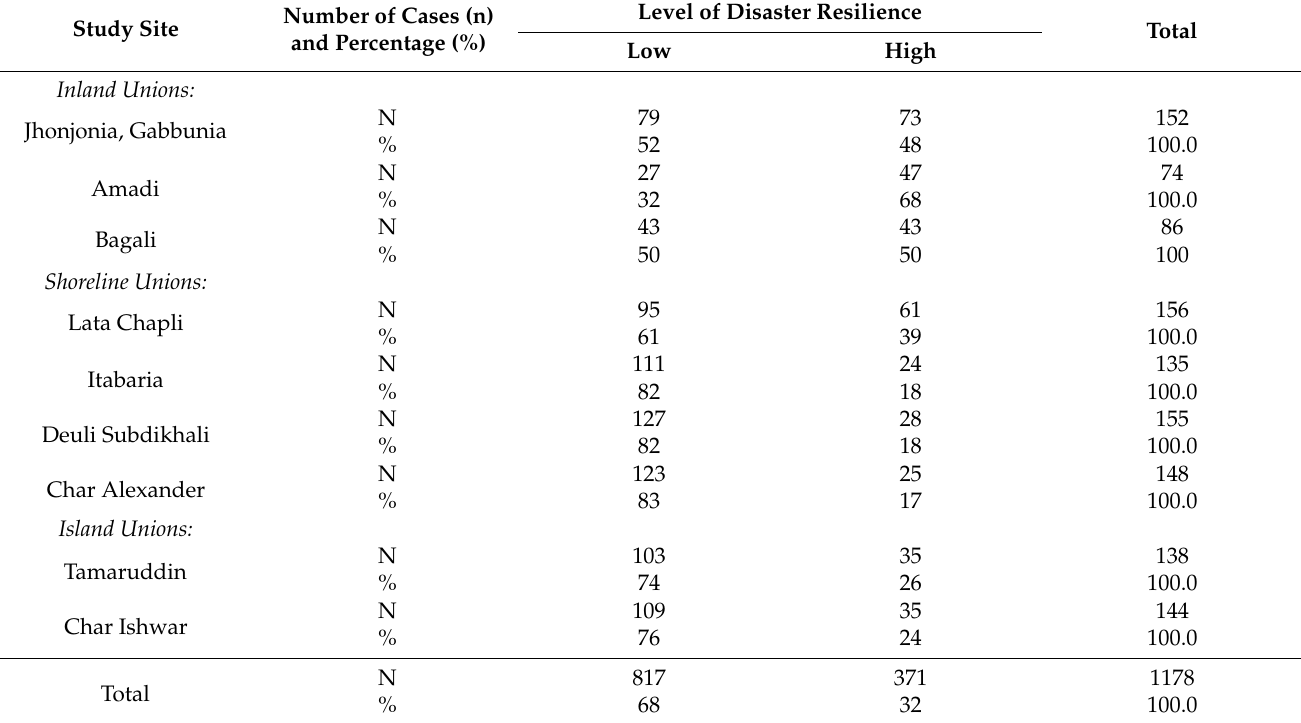
Table 12. Level of cyclone resilience of households in the study sites at the union level (N = 1188). Number of Cases (n) Level of Disaster Resilience Study Site